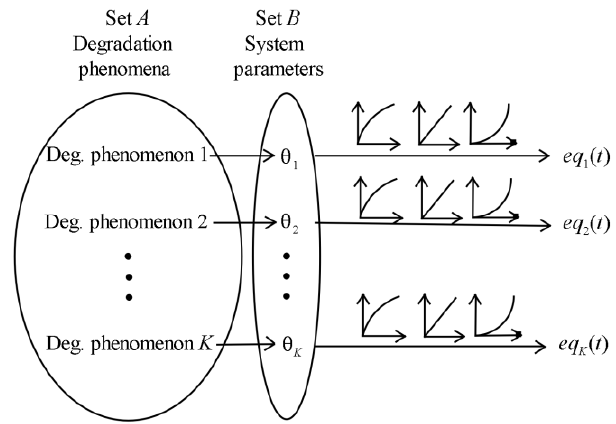
Figure 3. One-to-one correspondence (Bijection) between system degradation phenomena and system parameters.